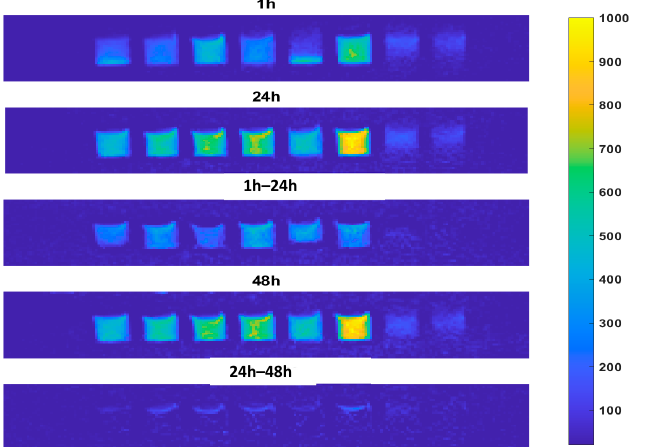
Figure 5. MR images show colloidal sedimentation of BPEI-coated IONRs under different conditions: water pH 3/pH 7, phosphate buffer solution (PBS), fetal calf serum (FCS), MEM. MEM/FCS, Opti-MEM, Opti-MEM/FCS and HEPES at room temperature after 1, 24 and 48 h. The difference found between 1 and 24 h is more than that which is found between 24 and 48 h. The colour codes are related to sedimentation in arbitrary units.